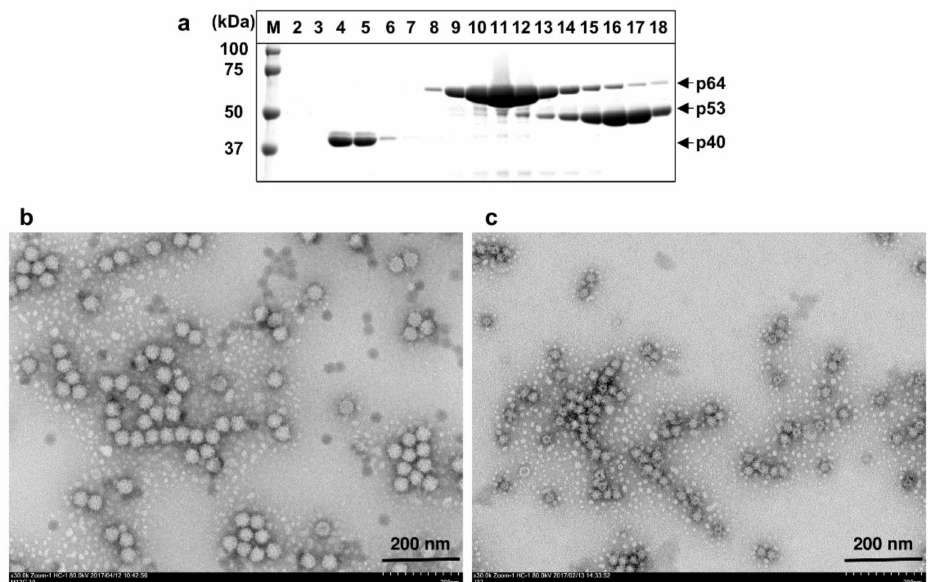
Figure 2. Purification of RnVLPs. Ac[Rn13ORF2]-infected Tn5 cells were harvested on day 7 p.i. and treated with denaturation buffer, and then purified by CsCl equilibrium density gradient centrifuga- tion. Aliquots from each fraction were analyzed by electrophoresis on 5–20% polyacrylamide gel and stained with CBB ( a ). RnVLPs ( b ) in fraction 11 and RsVLPs ( c ) in fraction 16 were observed by EM. Bar: 200 nm. M: molecular weight